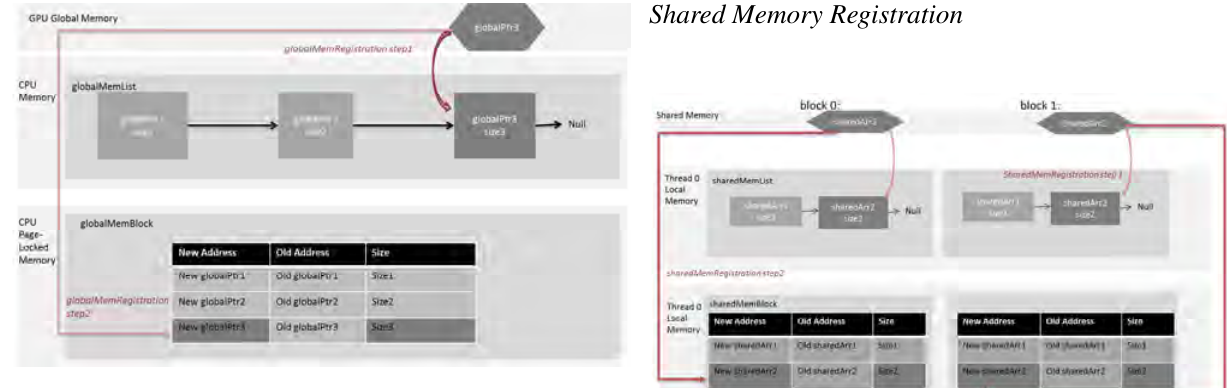
Fig. 6. Process Layout of Global Memory Registration